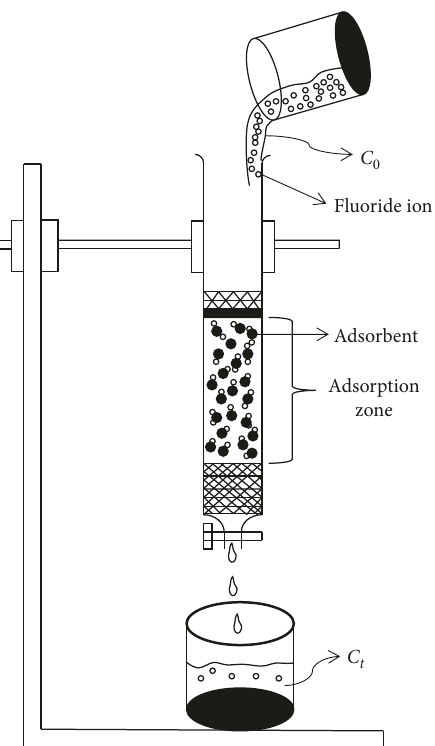
Figure 1: Schematic diagram of